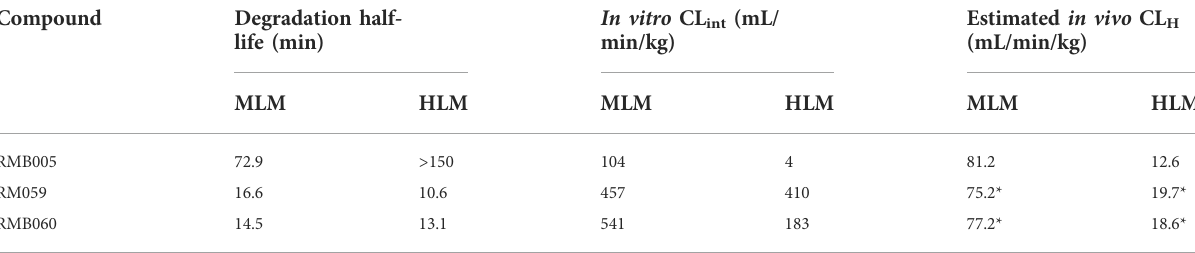
TABLE 3 Calculated intrinsic clearance (CL int ) of RMB005, − 059 and 060 using t 1/2 in HLM and MLM and estimated in vivo hepatic clearance (CL H ).